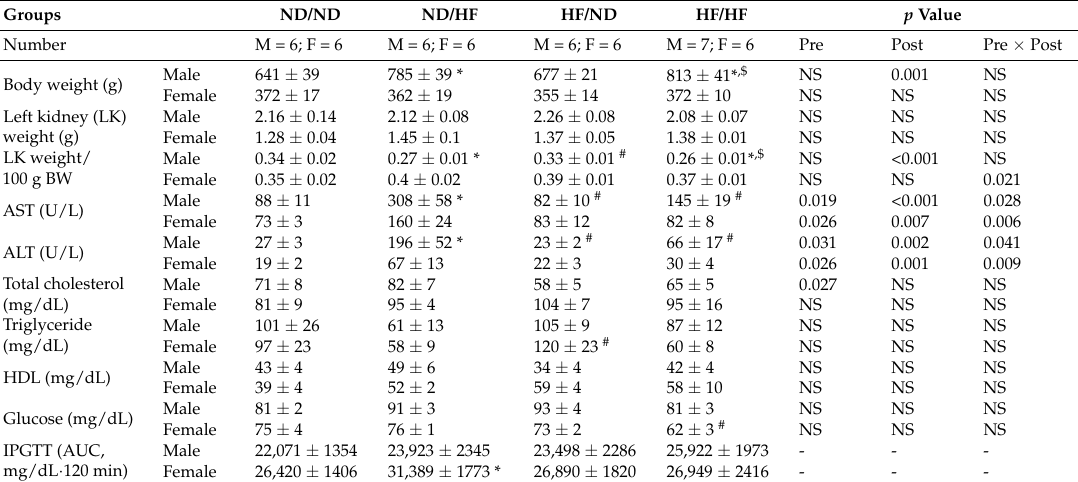
Table 2. Weights and metabolic parameters in offspring at six months of age.